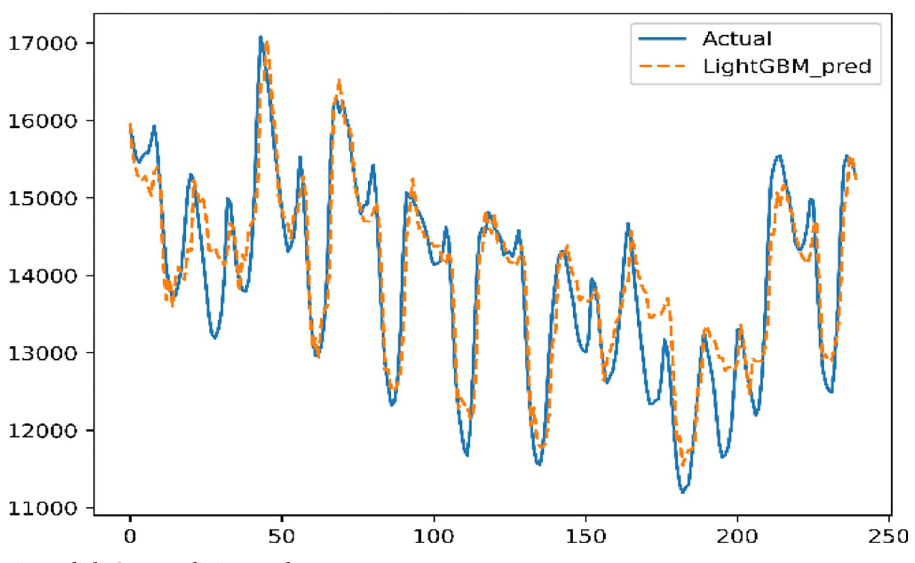
Fig 8. PlightGBM prediction results.